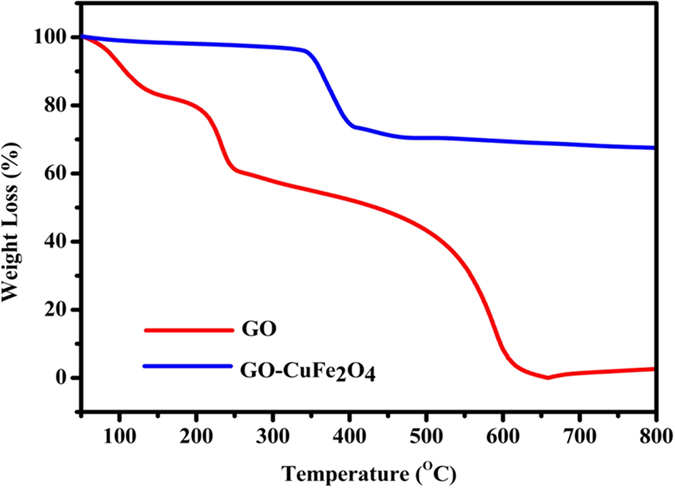
Thermogravimetric analysis (TGA) curves of GO, and GO-CuFe2O4 nanocomposite.